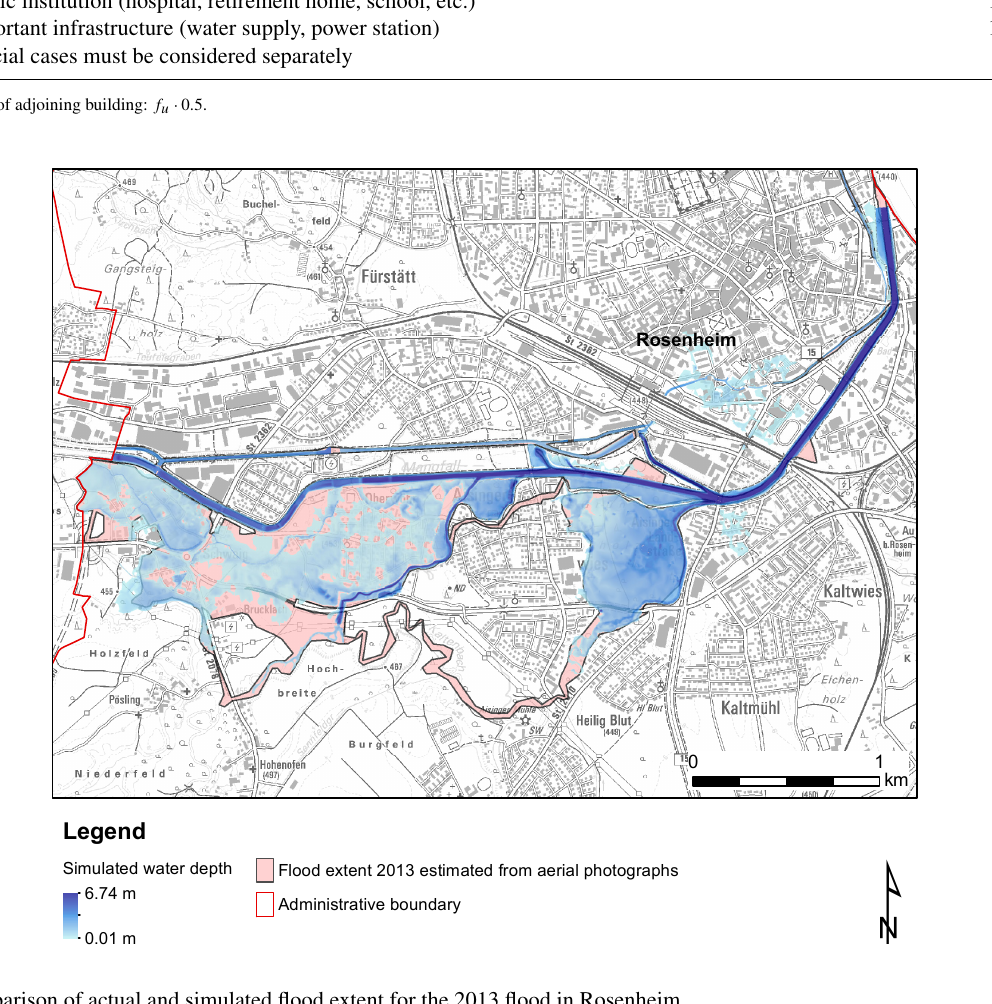
Figure 7. Comparison of actual and simulated flood extent for the 2013 flood in